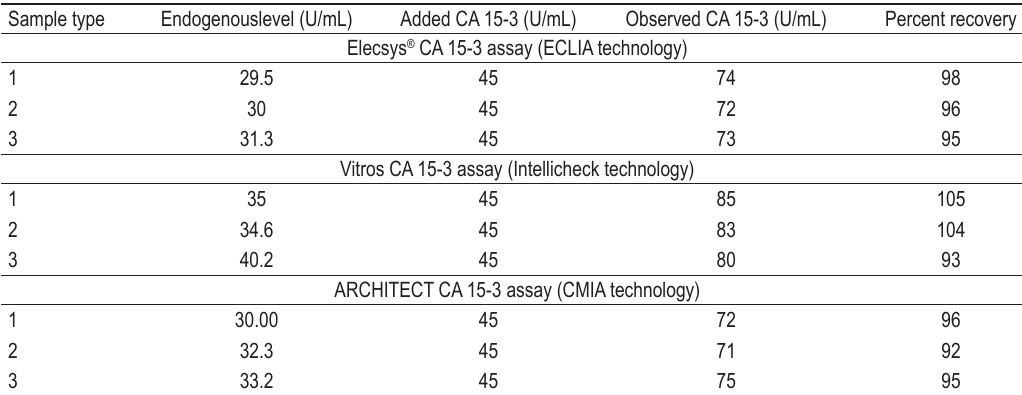
TABLE 2. Recovery testing Sample type